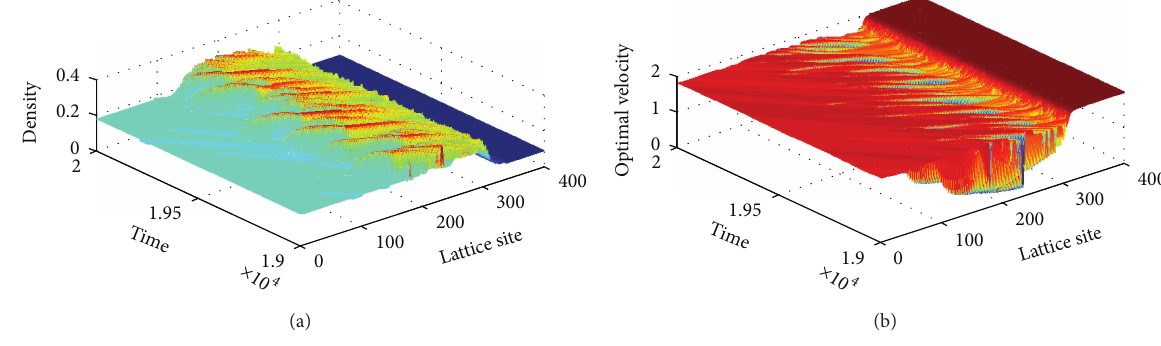
Figure 4: The spatiotemporal evolutions of PLC for 𝜌 ℎ = 0.08 , 𝑄 on = 0.13